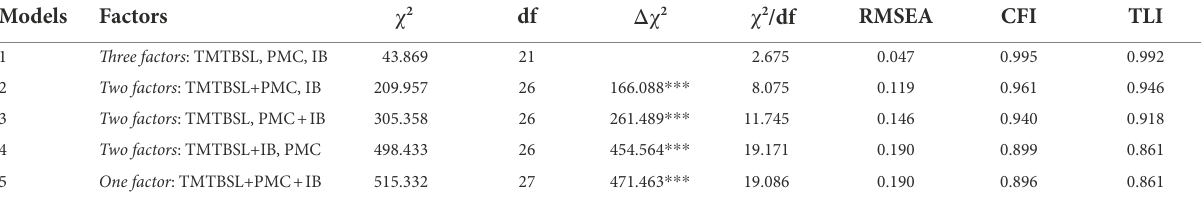
TABLE 5 Comparison of alternative measurement